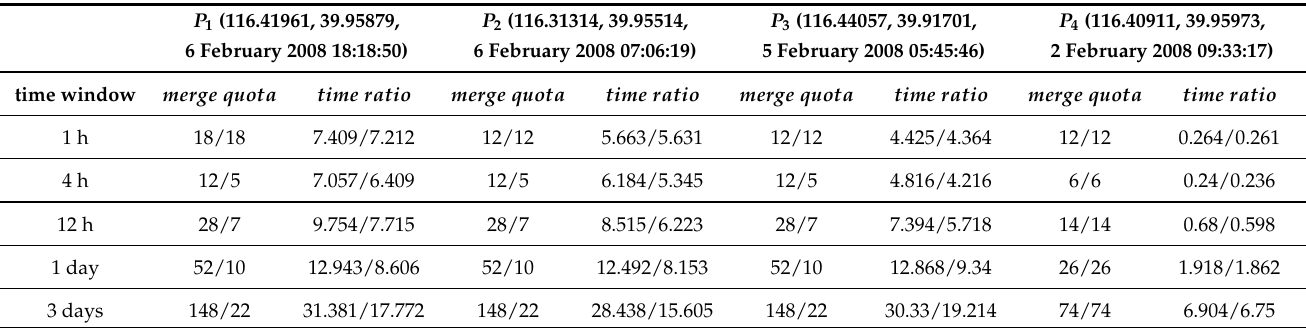
Table 3. The effect of merging query codes on spatio-temporal range query with different time windows.